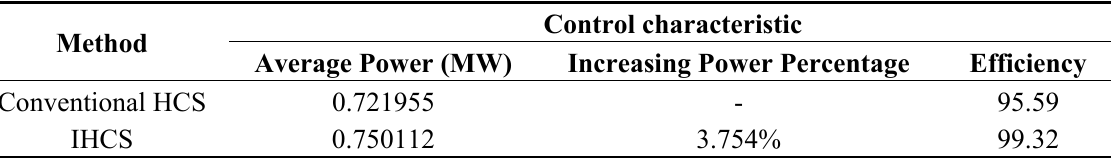
Figure 12. Variation of efficiency. Table 3. Comparison with conventional HCS and